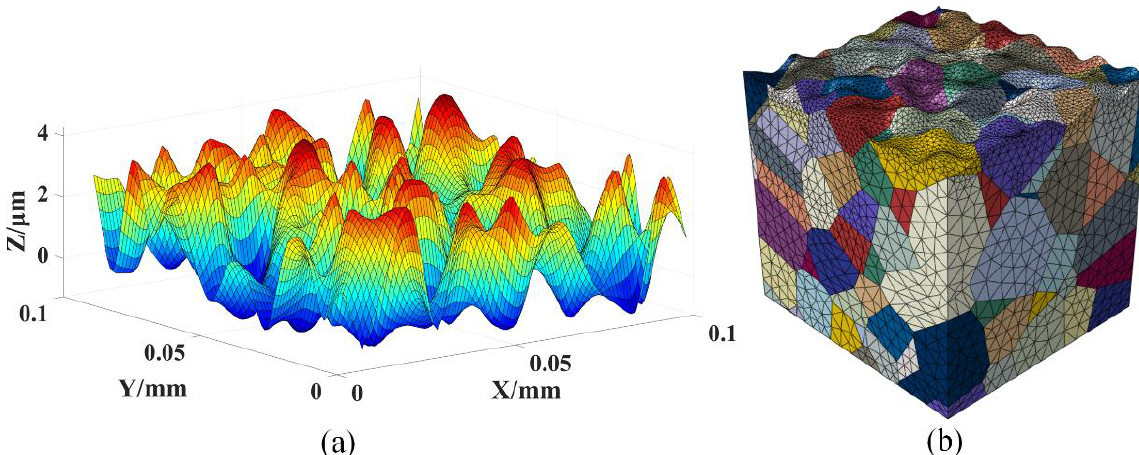
Figure 1. ( a ) The randomly generated roughness profile with a surface roughness of 1.6 μm; and ( b ) The 3D polycrystalline finite element model with initial roughness within 0.1 mm × 0.1 mm × 0.1 mm.